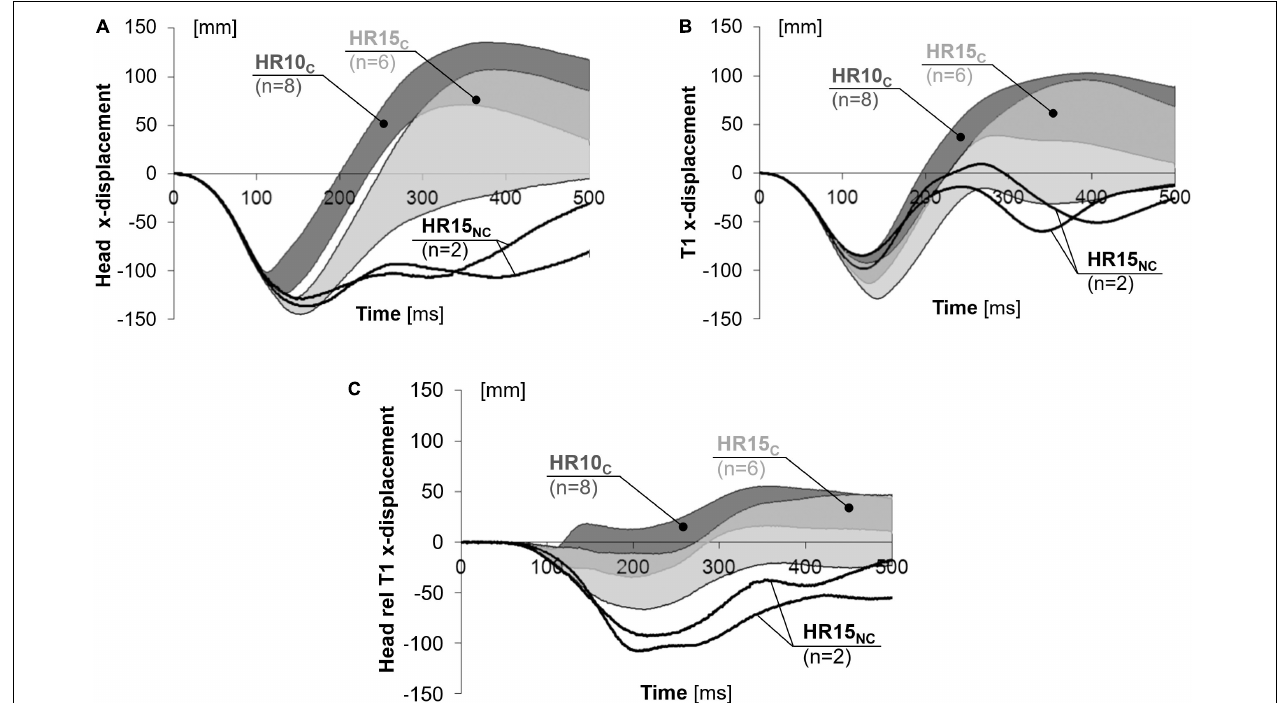
FIGURE 3 | X-displacement of the (A) head, (B) T1, and (C) head relative to T1 for near 50th percentile female